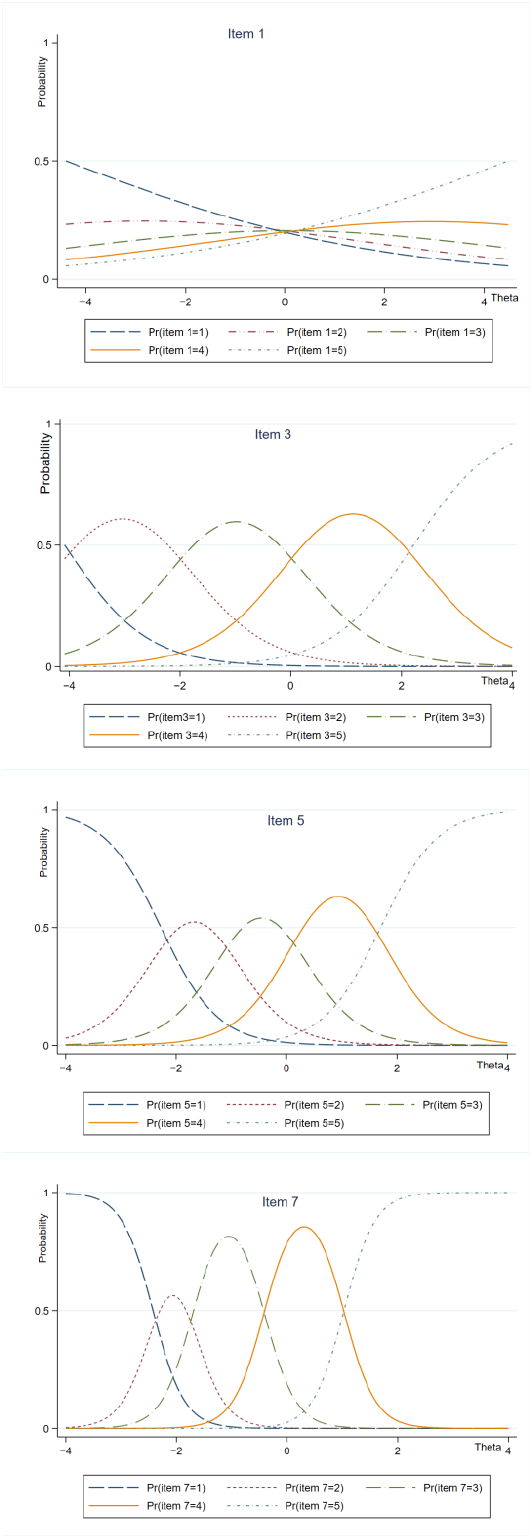
Figure 4 is the matrix diagram of the project characteristic curve (ICC) of each item. Under ideal conditions, the first and fifth curves of ICC change monotonously, and the second and fourth curves are normal distribution. The results show that the ICC curve distribution of items 1 and 2 is not ideal, and the ICC curve of other items is